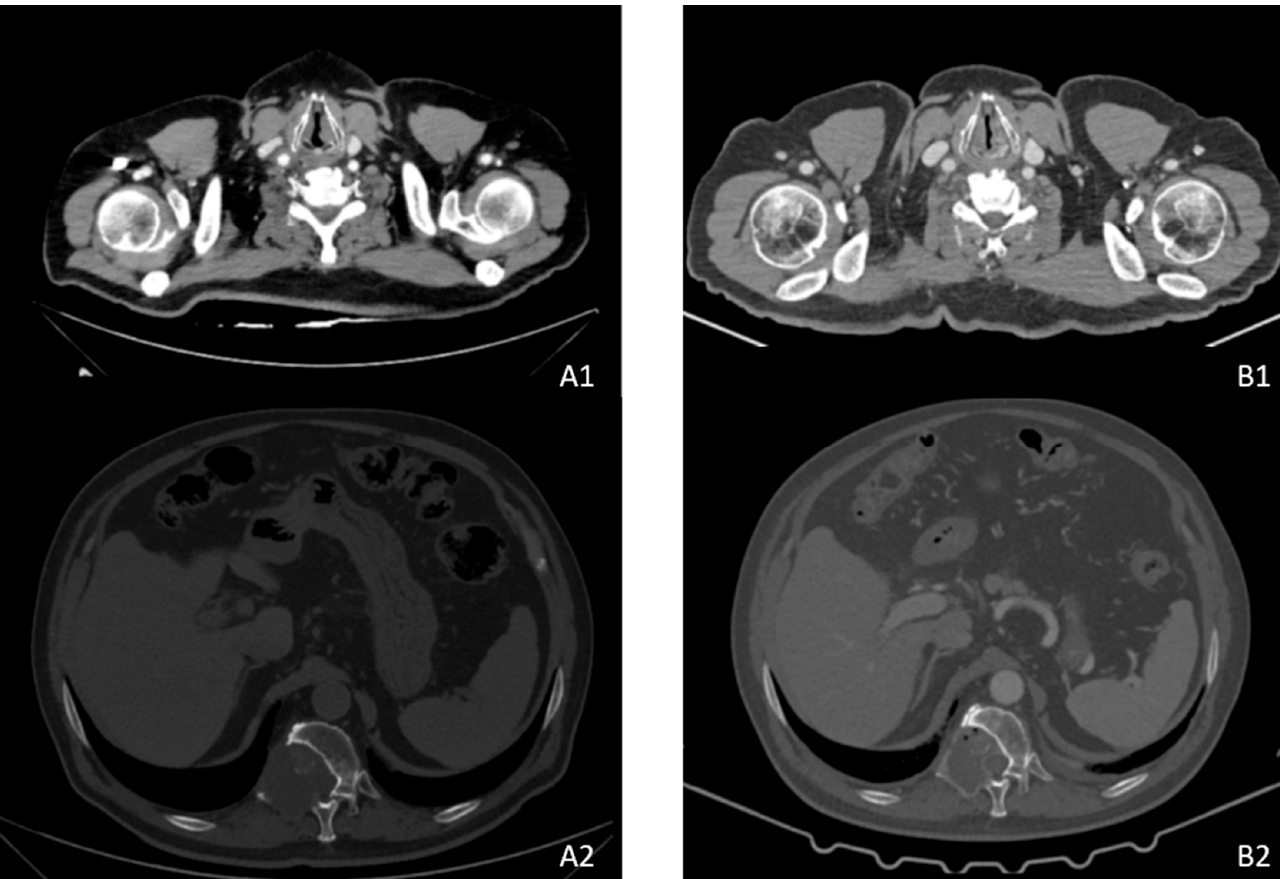
Figure 4. ( A1 , A2 ) Total-body CT scan August 2021; ( B1 , B2 ) total-body CT scan January 2022.